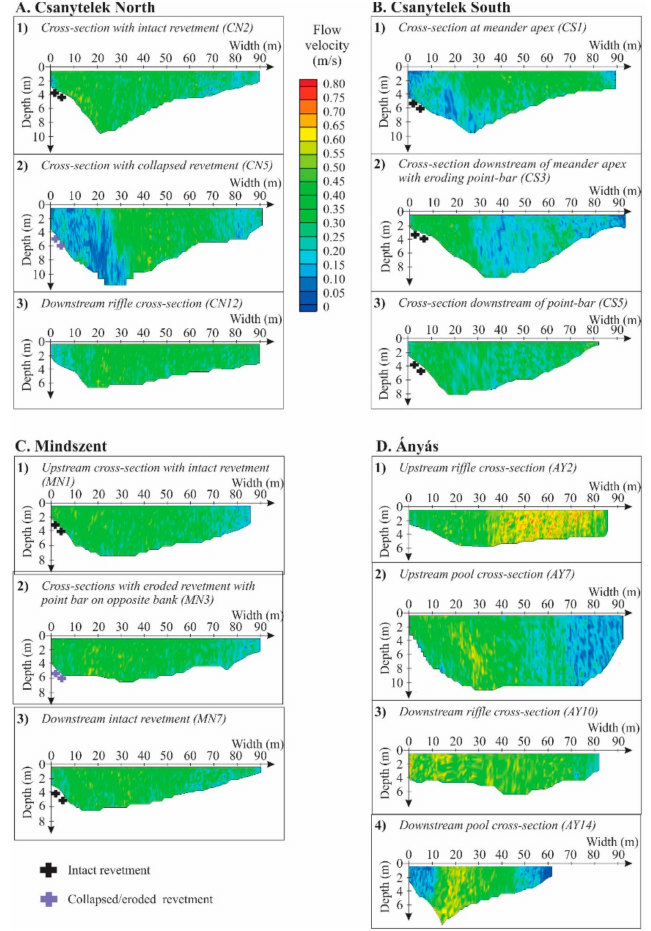
Figure 11. Typical velocity fields of the morphological units of the study sites at ( A ) Csanytelek North, ( B ) Csanytelek South, ( C ) Mindszent, and ( D ) Á ny á s. The existence and state of the revetment is indicated by